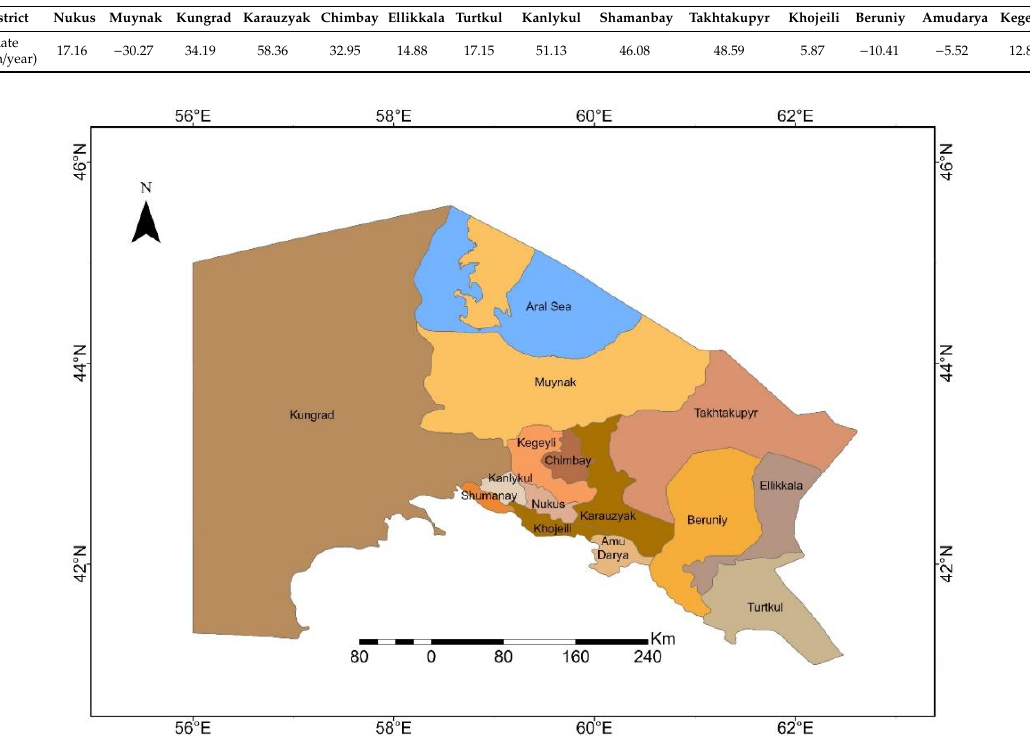
Table 2. Groundwater level variation rate from 1999–2017.